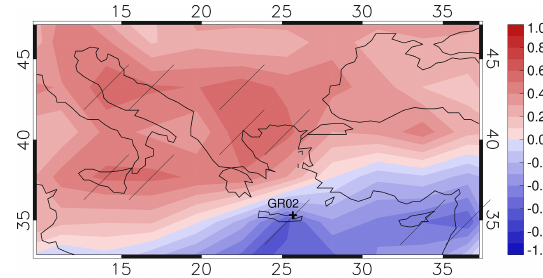
Figure 9. Spatial distribution of the correlation coefficient between July–August average values of near-surface ozone at Finokalia and July–August average values of tropopause fold frequency at each grid point over the period 1998–2013. Areas featuring correlation coefficients that are statistically significant at the 95% confidence level are